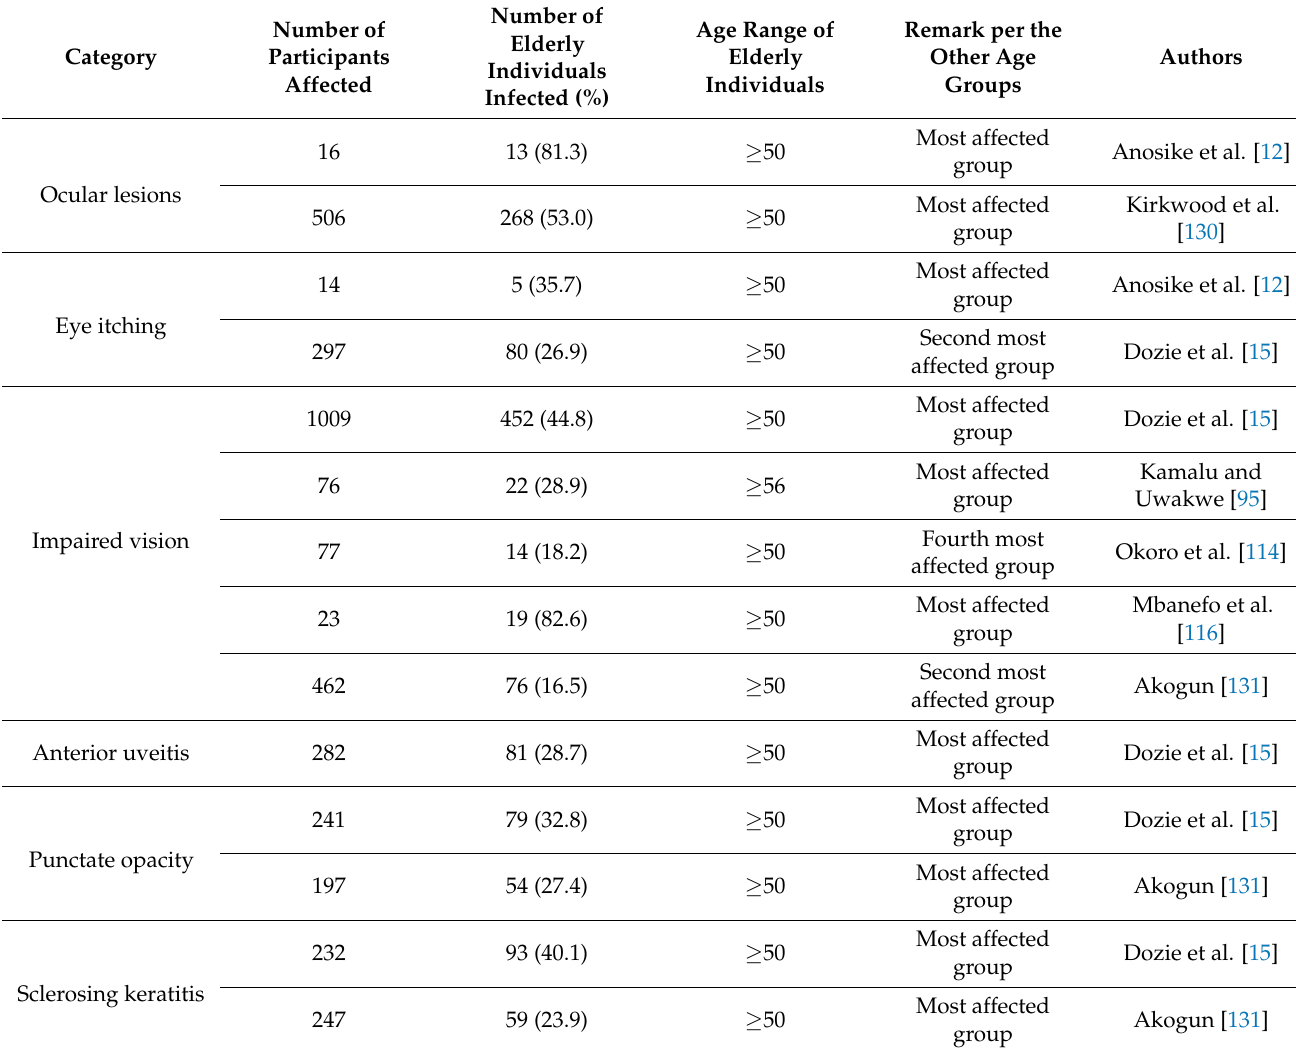
Table 4. Distribution of ocular lesions in the older